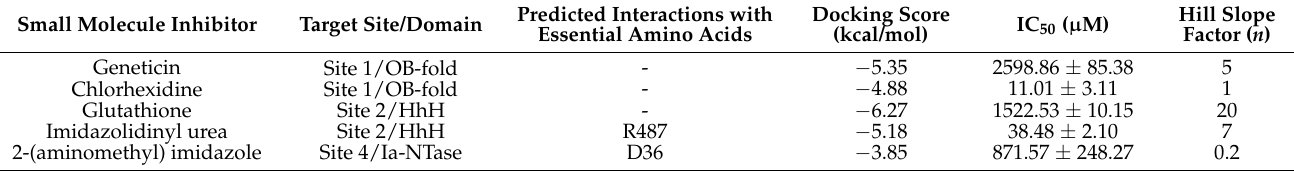
Table 1. A summary of the inhibitory properties of the five small molecule inhibitors of EC-LigA. Small Molecule